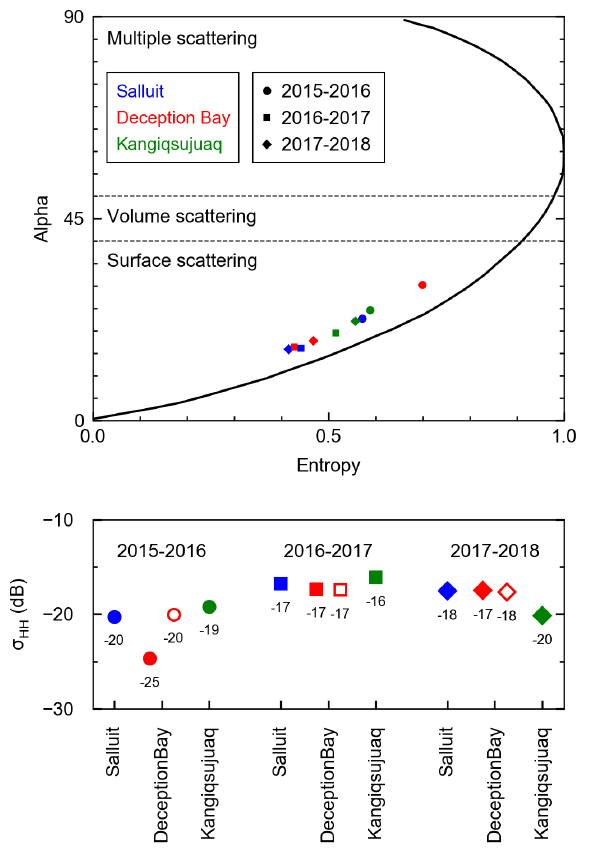
Figure 5. Seasonal median SAR parameters for Salluit, Deception Bay, and Kangiqsujuaq in 2015– 2016, 2016–2017, and 2017–2018. Top: Alpha angle versus entropy in the C-band, plotted in the Cloude–Pottier H-alpha plane [39]. Bottom: HH backscattering coefficients in the C-band (full markers) and X-band (empty